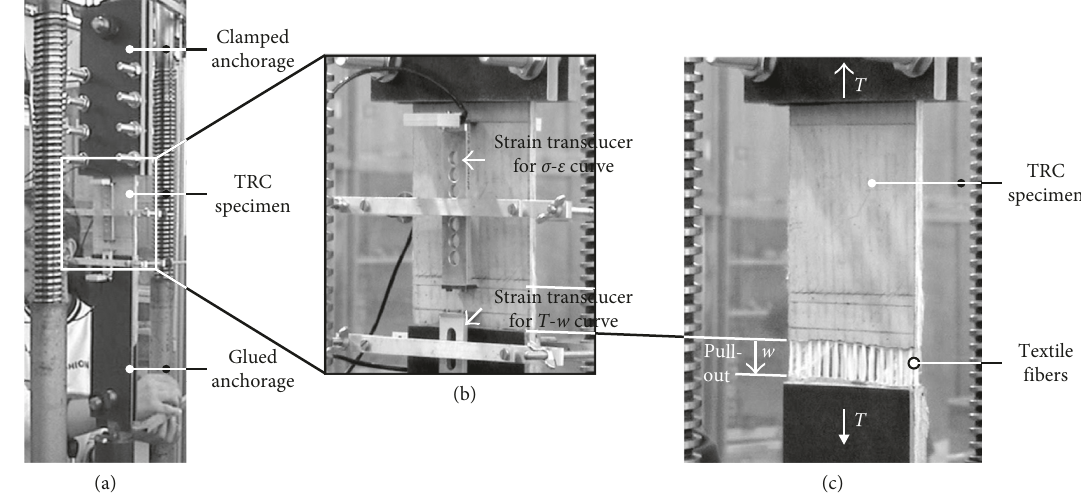
Figure 9: Measurement instrumentation of the test setup. (a) Test setup, (b) detail of measurement, and (c) textile